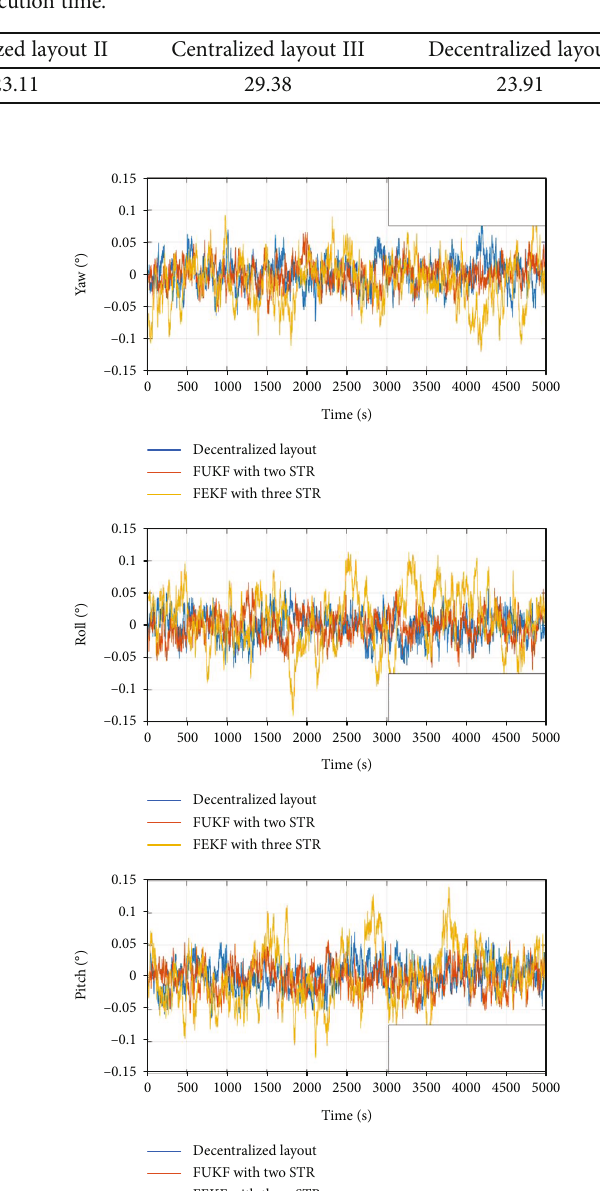
Figure 12: Estimation error of Euler angles (stable